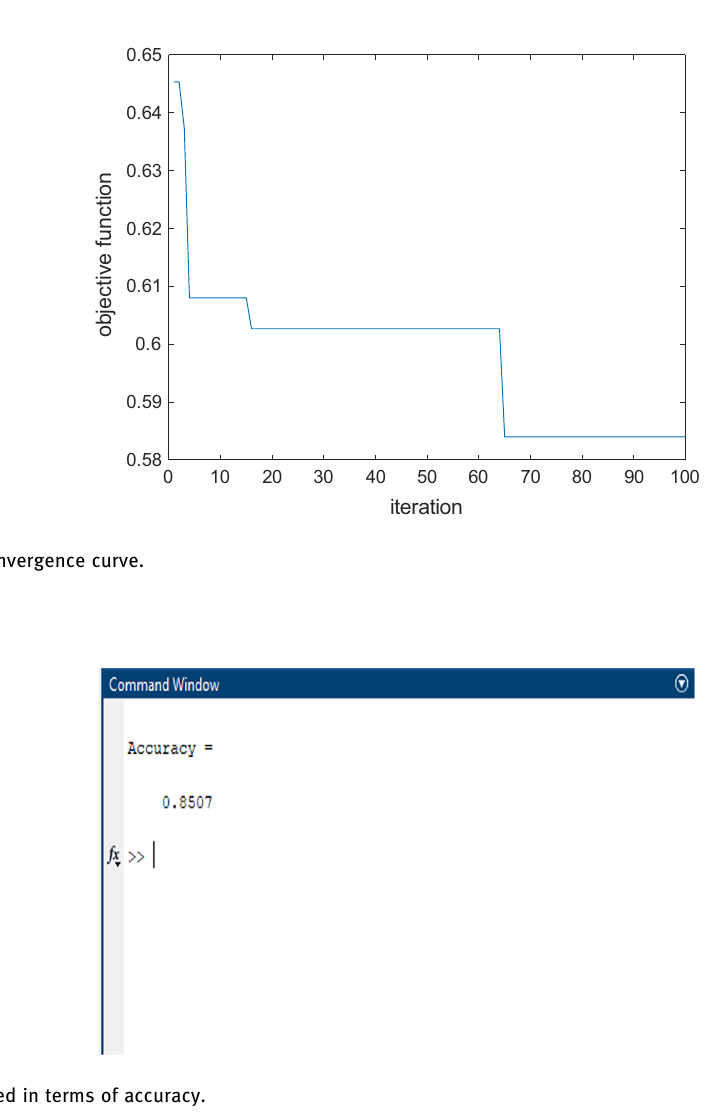
Figure 9: Evaluated in terms of accuracy.